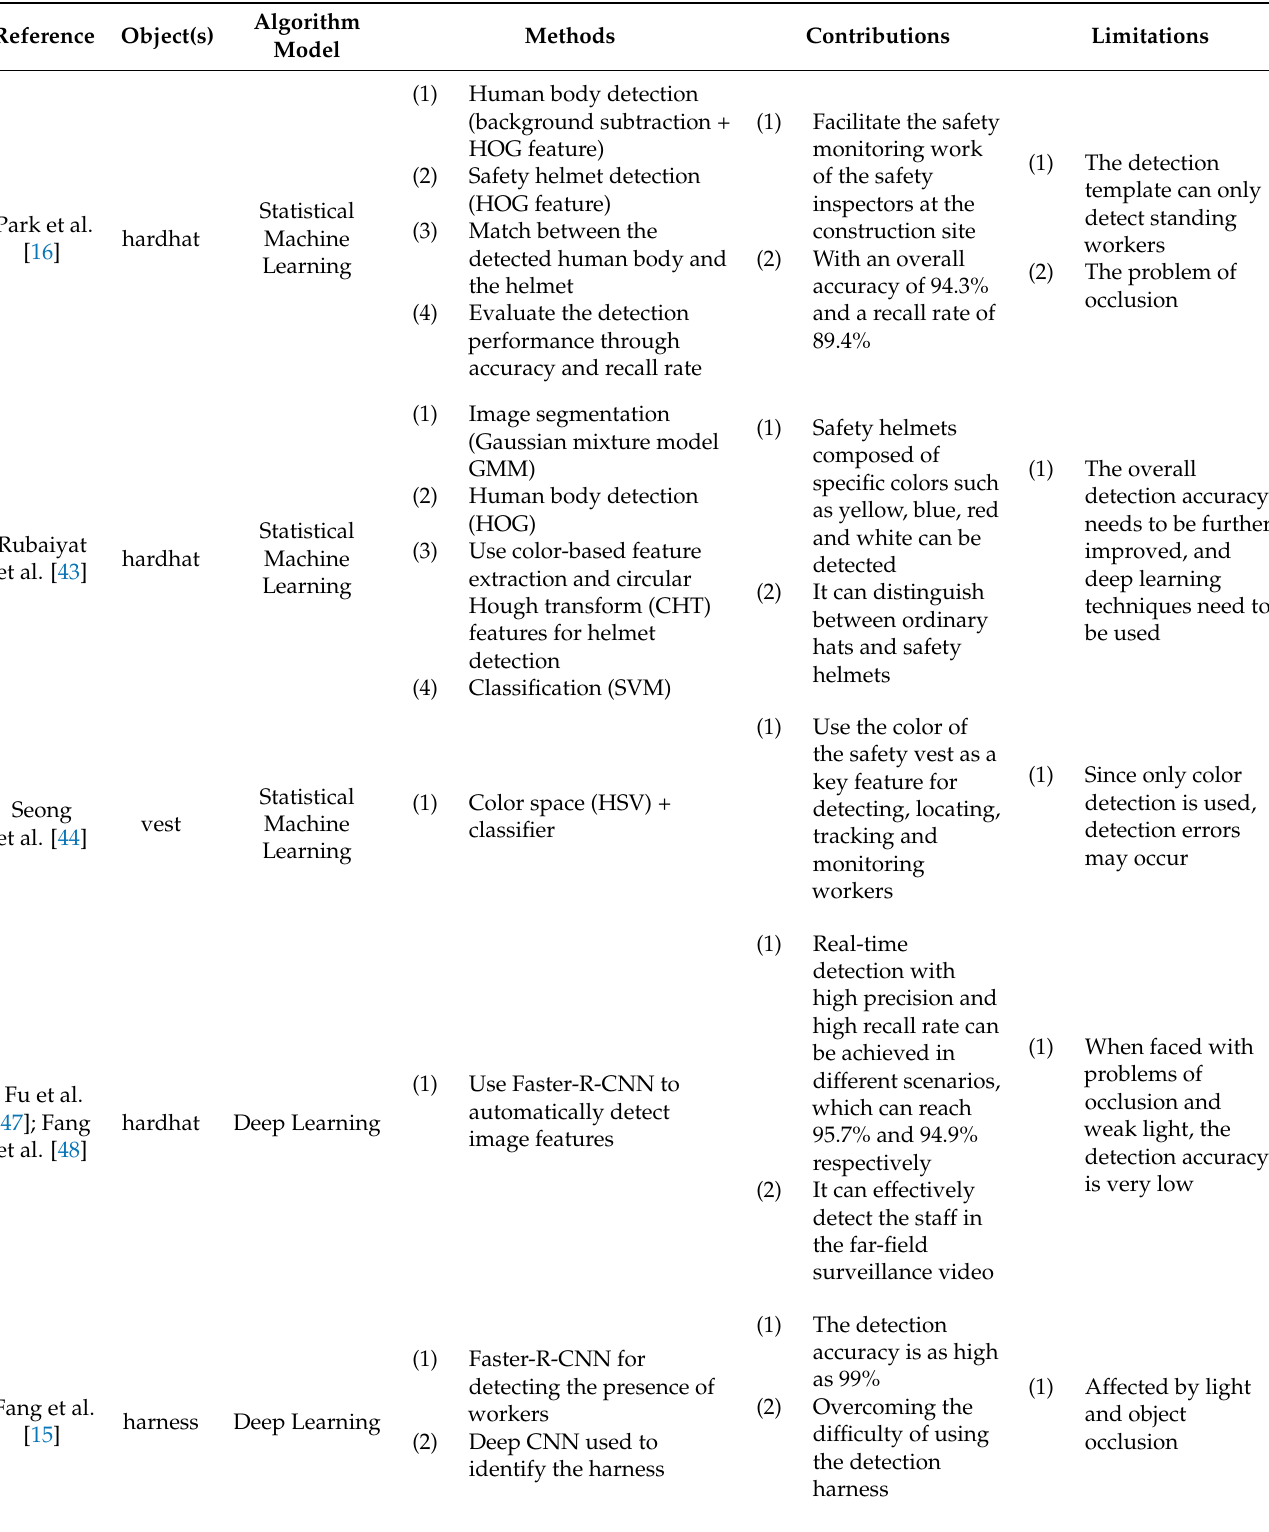
Table 1. Research details of worker PPE-use